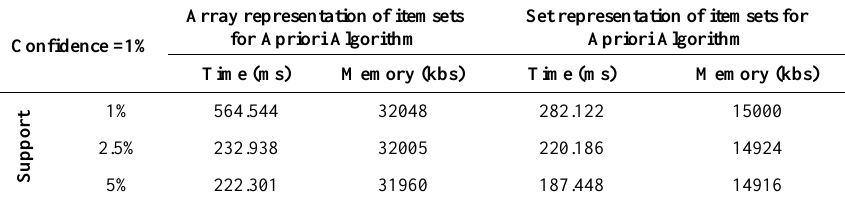
Table 2. Array and set representation of itemsets for Apriori Algorithm with confidence value=1% and Support =1, 2.5, and 5%. Array representation of itemsets Set representation of itemsets for for Apriori Algorithm Apriori Confidence =1%